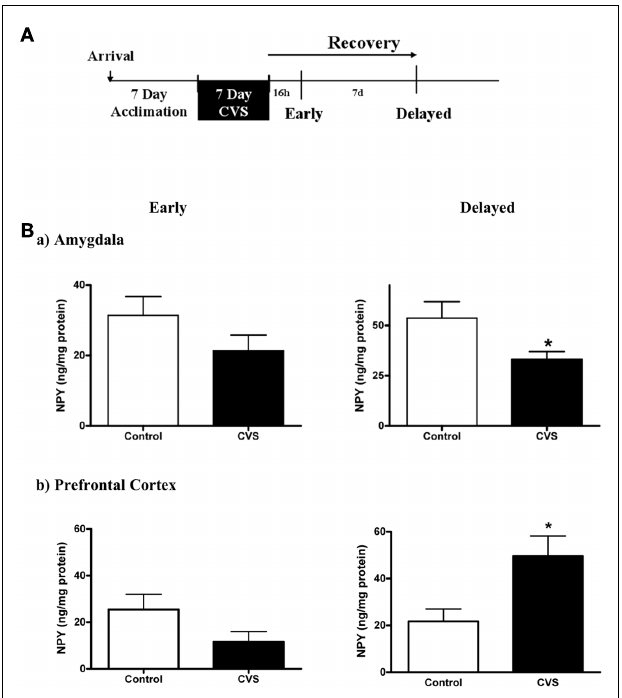
FIGURE 1 | Changes in NPY protein in early and delayed recovery from chronic variable stress (CVS) (A). Schematic of experimental design and tissue collection. (B) . Significant changes in NPY tissue content emerge during recovery from CVS. NPY is decreased in amygdala (a) and increased in prefrontal cortex (b) 7days after cessation of CVS as measured by ELISA. NPY content is not different in either region when tested 16h after CVS completion. “*” Indicates p < 0.05. Data is represented as mean ± SEM.